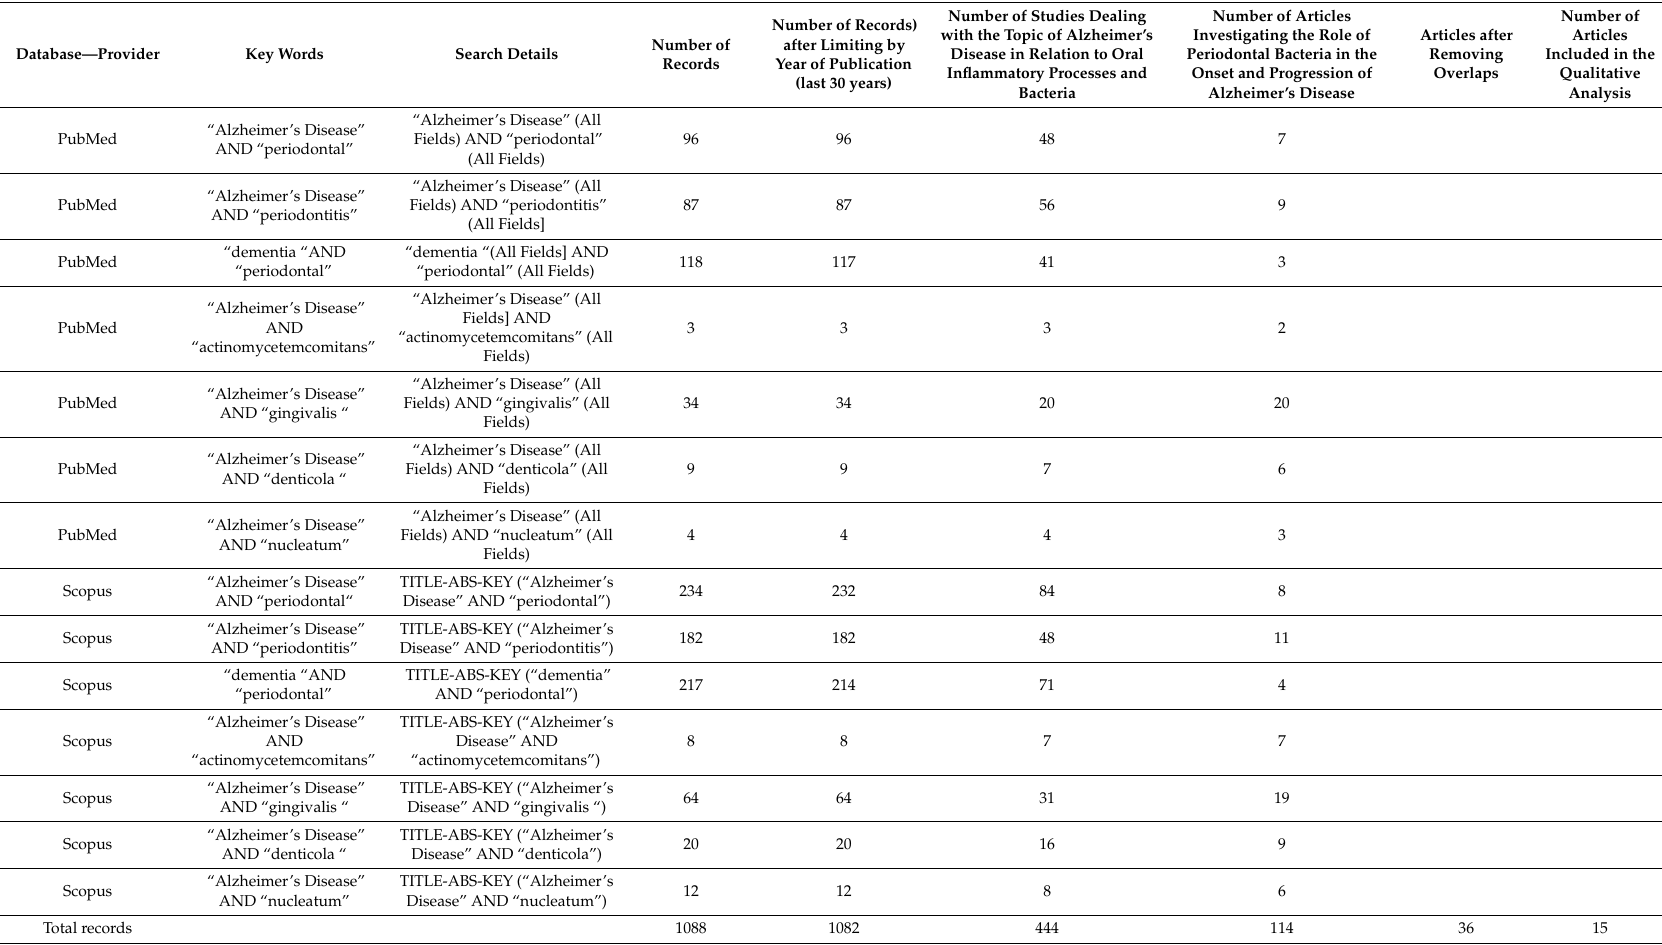
Table 1. Complete overview of the search methodology. Records identified by databases: 1088; records selected for qualitative analysis: